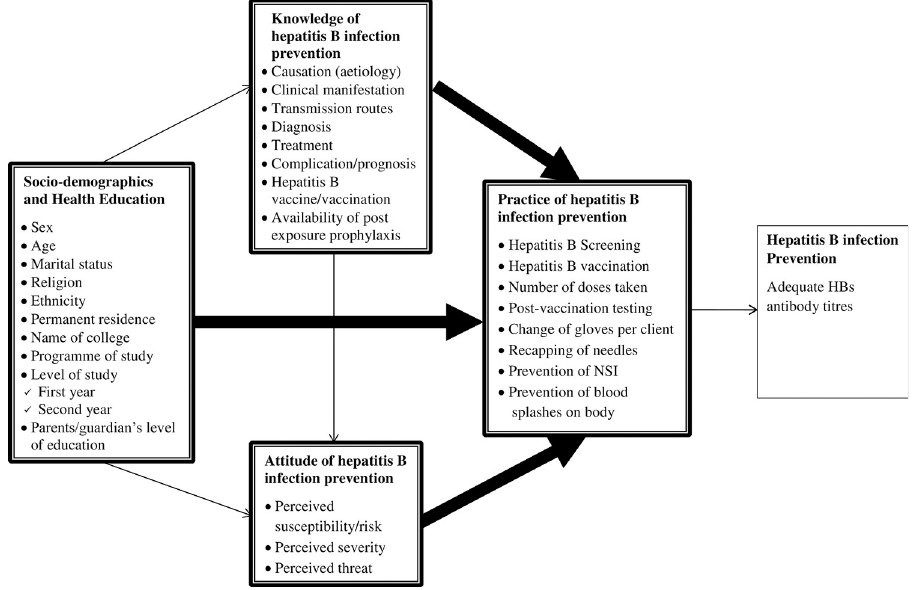
Fig 1. Conceptual framework of the